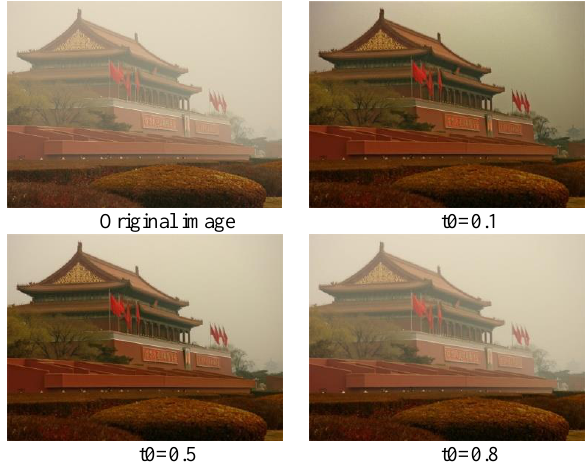
Figure 1. Comparison of different t0 values on image effects